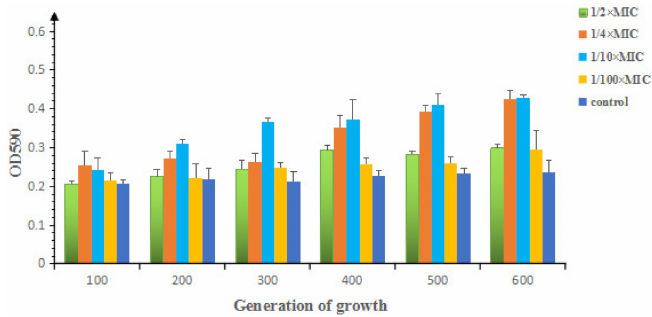
Figure 2. Biofilm formation of E. coli ATCC25922 induced by sub-MICs of